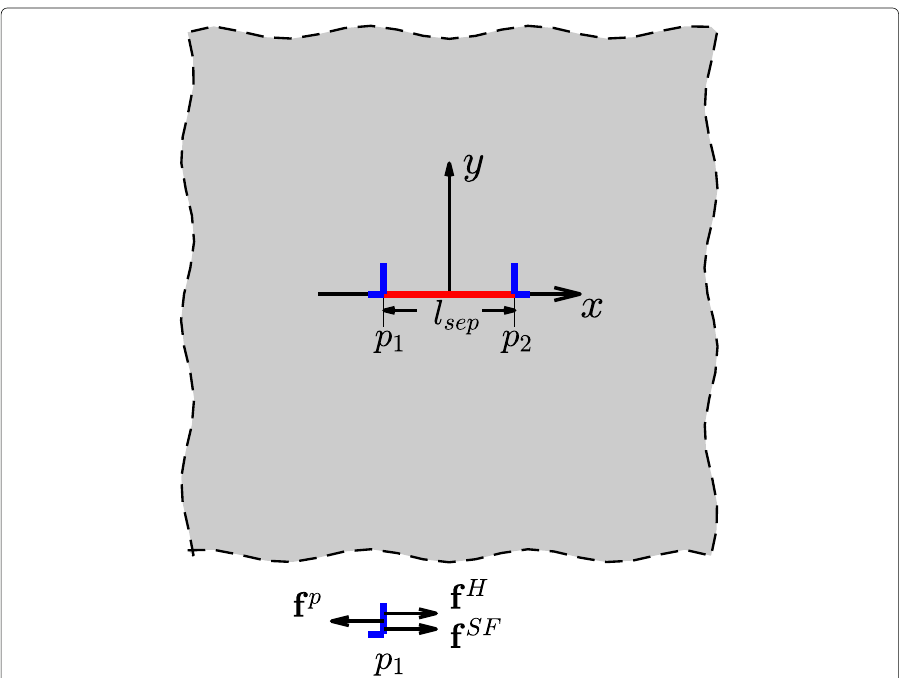
Fig. 4 Schematic diagram of an infinitely long disassociated edge dislocation in an infinite volume. The red line represents the stacking fault and the blue “ (cid:2) ” symbols represent the partial dislocations. The Burgers vector is parallel to the x-direction and the direction of the different forces on the partial dislocation is shown. The red line represents the stacking fault